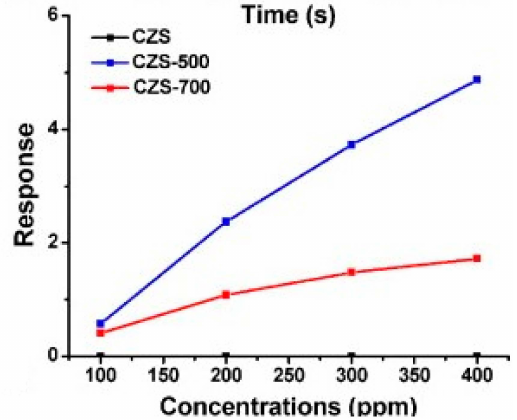
Figure 70. Ethanol sensing response of C doped ZnO microspheres with different calcination temperatures. Reproduced with permission from [101].